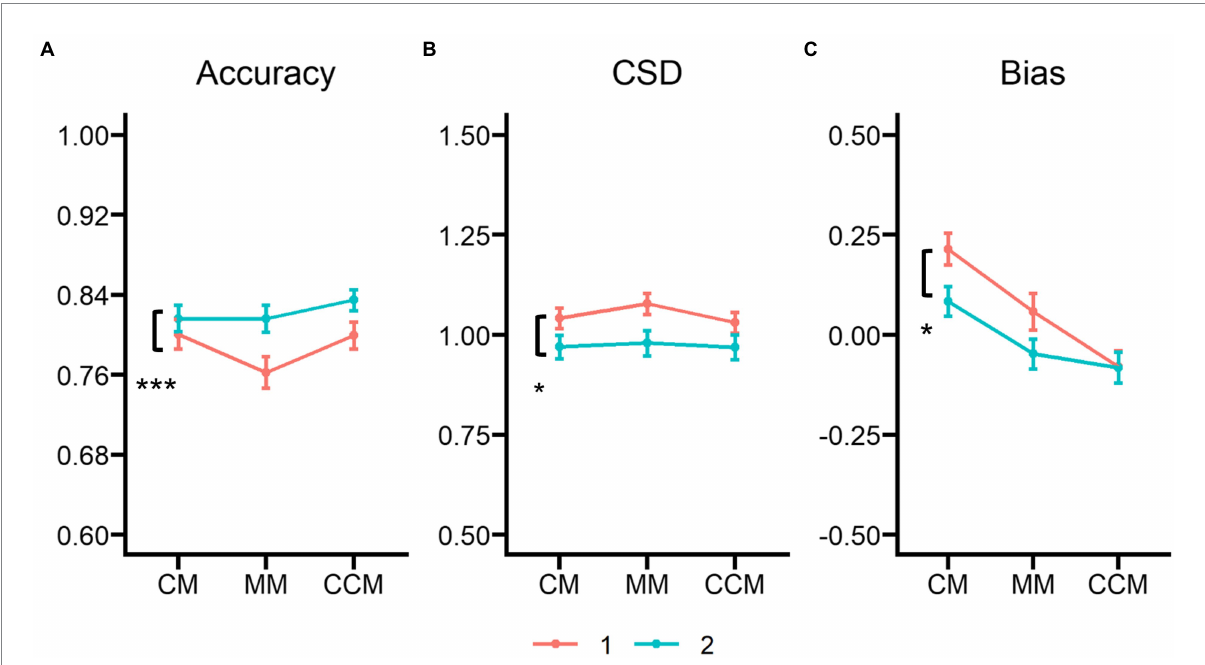
FIGURE 6 Results of the combined analysis of Experiments 1 and 2 for the matching conditions on (A) VWM accuracy, (B) the ensemble circular standard deviation (CSD) of the mean identity estimations, and (C) the ensemble bias parameter of the mean identity estimations. CM, clockwise matching condition; MM, mismatching condition; CCM, counterclockwise condition. * p < 0.05, *** p <